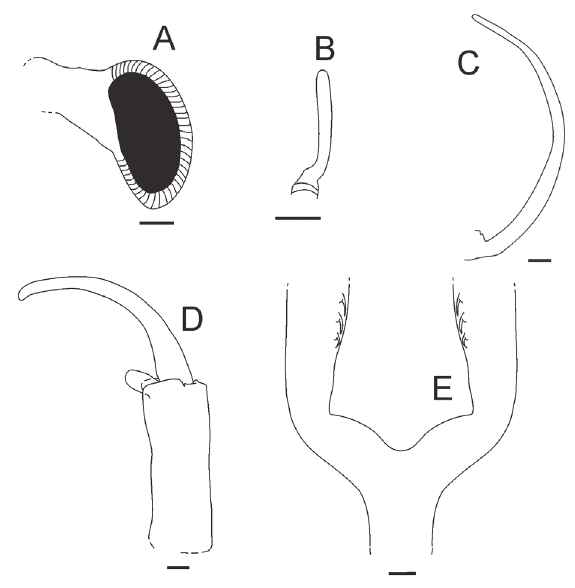
Figure 2. Dendrocephalus brasiliensis Pesta, 1971, male from Porto Real do Colégio, Alagoas, Brazil (CARCINO 104). A) male pedunculate eye; B) antenna-like structure; C) first antenna; D) second antenna; E) basal part of the arms. Scale bars = 0.2 mm.